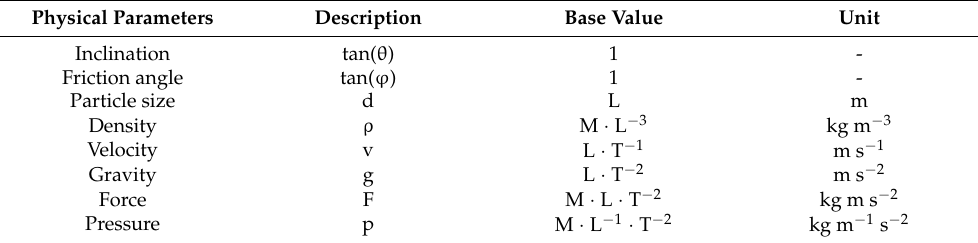
Table 4. Physical parameters regarding the determination of gravitational mass movement